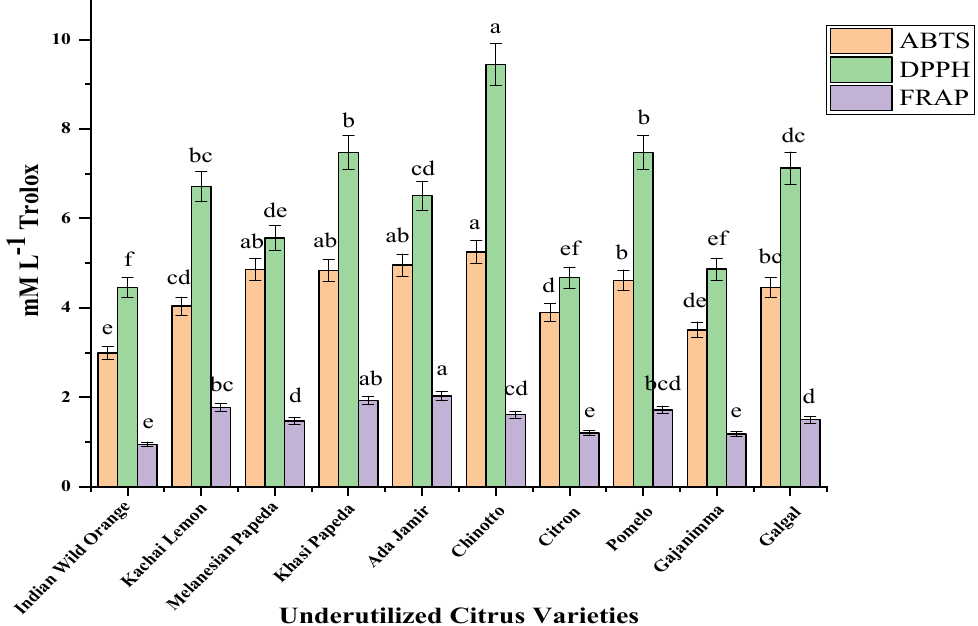
Figure 3. Antioxidant activity by ABTS, DPPH, and FRAP method in underutilized citrus varieties. Significant ANOVA p < 0.01. Letters a to f above mean (n = 3) bars denote significant differences at p < 0.01 according to Tukey’s HSD test.